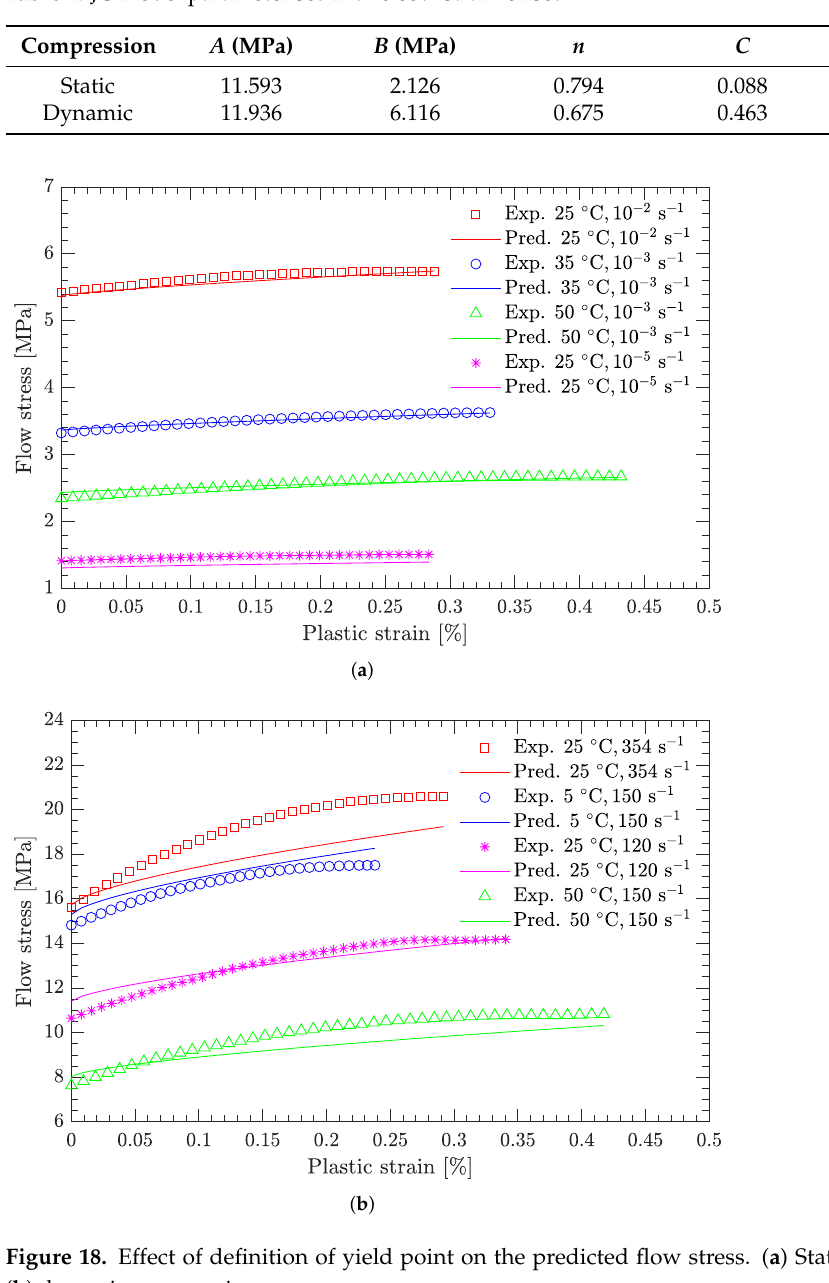
Table 2. JC model parameter set with 0.08% strain offset.